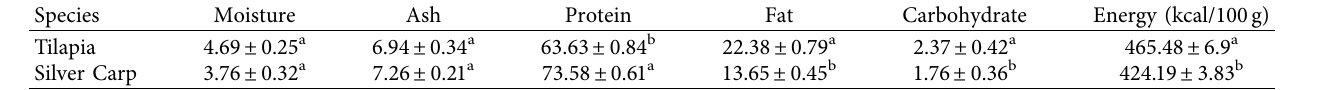
Table 4: Proximate composition of Tilapia and Silver Carp fsh powder (g/100g).